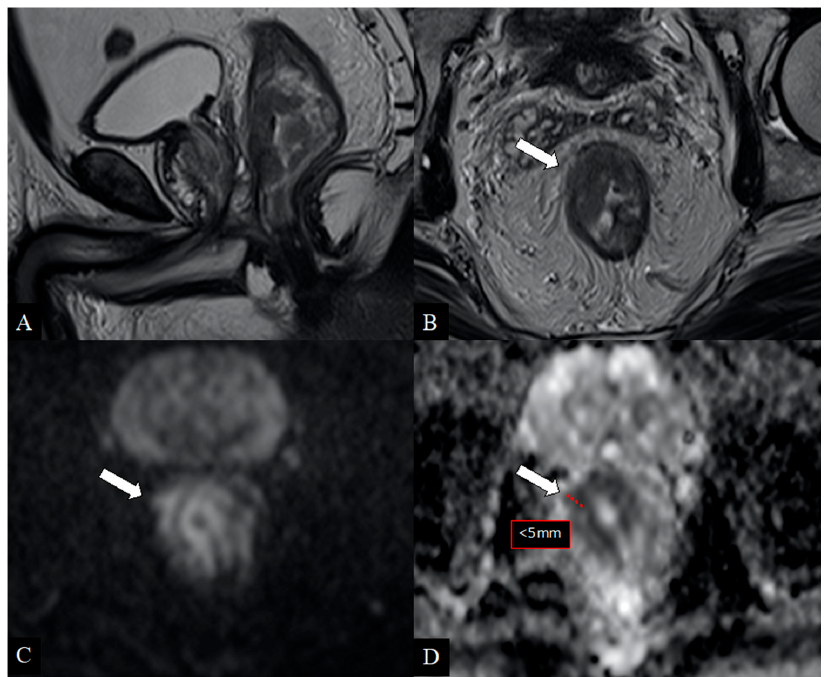
Figure 2. 58-year-old woman with histologically proven rectal adenocarcinoma. High-resolution axial T2 image ( A ) demonstrates a rectal neoplasm associated with a markedly hypointense tissue with irregular borders and retracting appearance (arrow) suggestive of an inflammatory/desmoplastic reaction in the contiguous mesorectal fat (T2 stage). The diffusion-weighted axial images ( B ) with relative apparent diffusion coefficient (ADC) map ( C ) reveal a hypercellular tissue with marked diffusivity restriction (low ADC values; inset) suggestive for neoplastic infiltration of the mesorectum > 5 mm (arrow). The histological examination confirmed the mesorectal infiltration and the preoperative staging (stage: T3c).